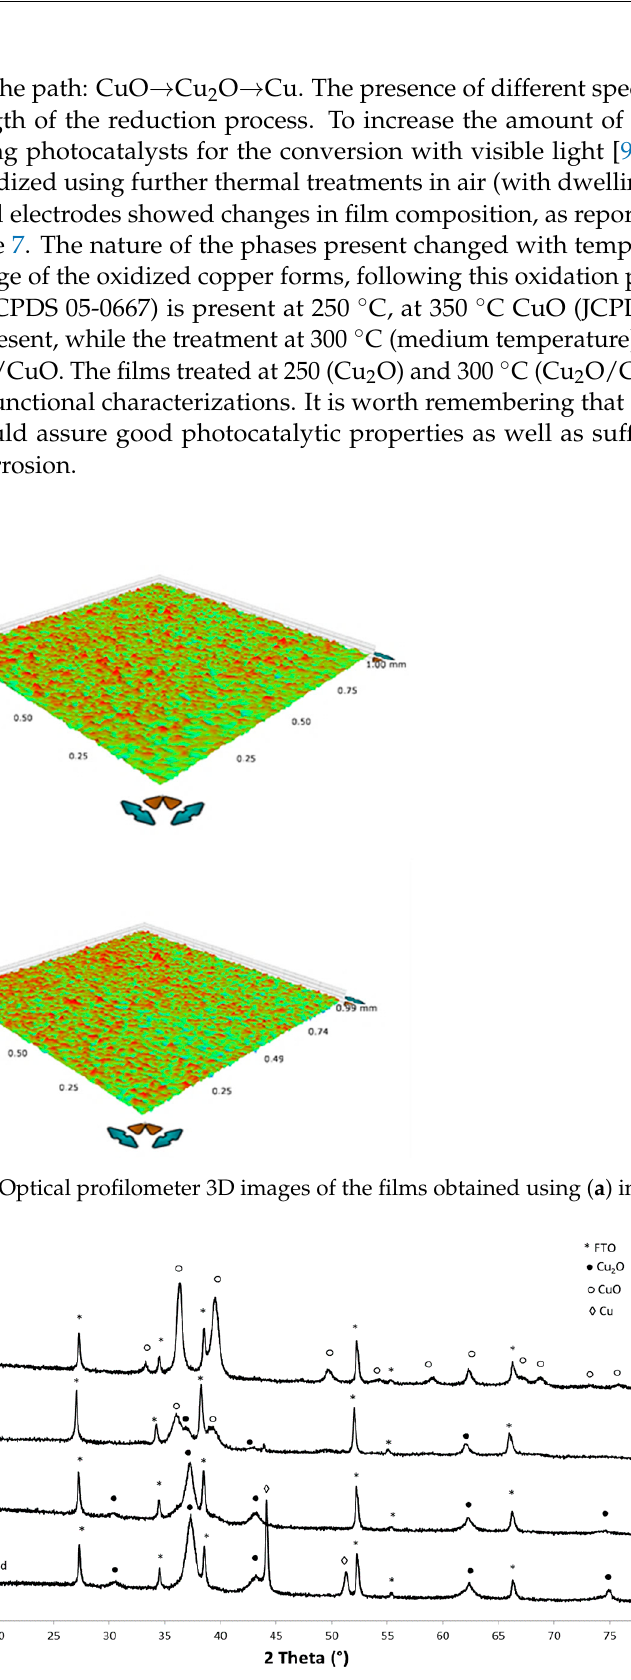
Figure 7. XRD patterns of the as-sintered electrode (as-treated) after oxidation treatment at 250 and 350 °C for 30 min.